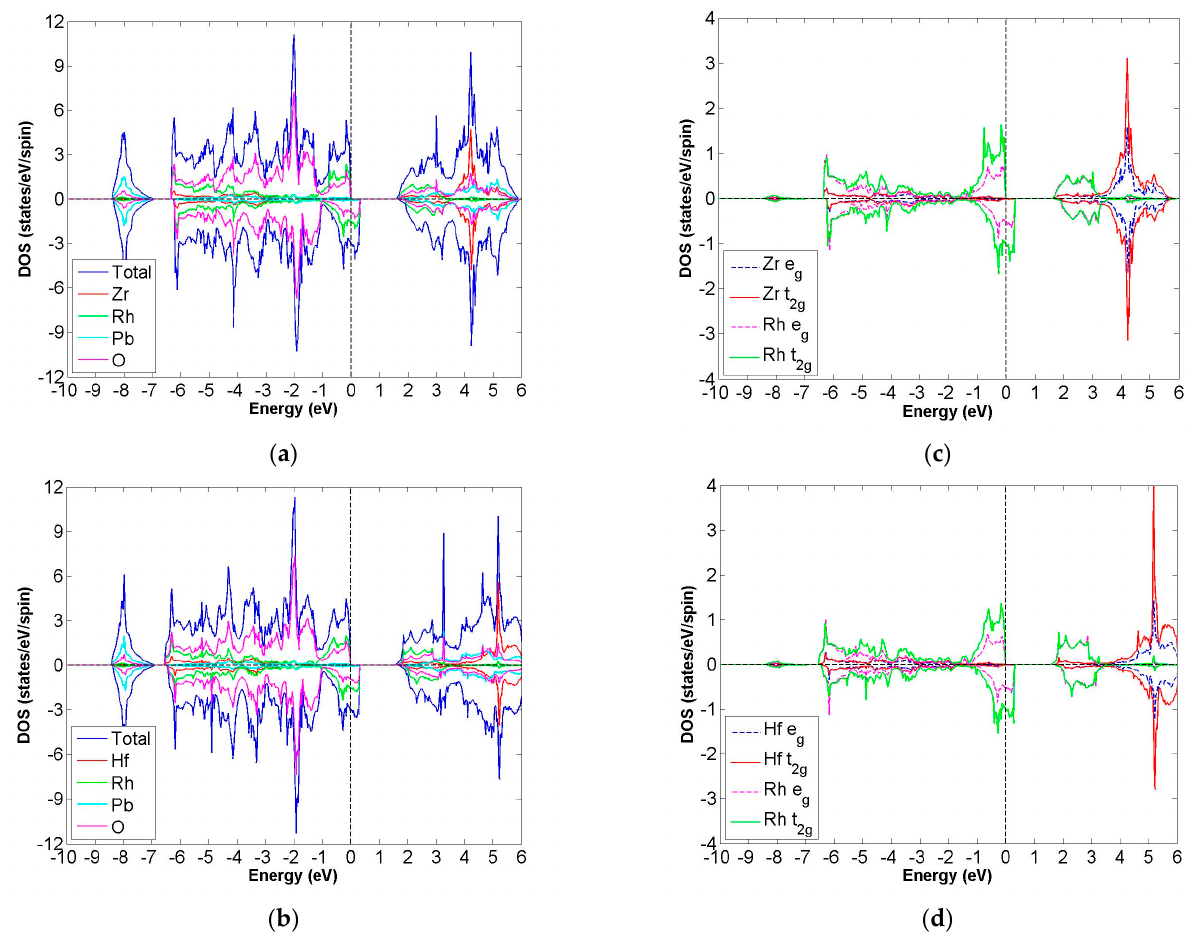
Figure 9. Based on the GGA calculation, the calculated total and partial DOS values of ( a ) Pb 2 ZrRhO 6 and ( b ) Pb 2 HfRhO 6 and partial DOS of e g and t 2g spin orbitals for ( c ) Zr and Rh and ( d ) Hf and Rh.